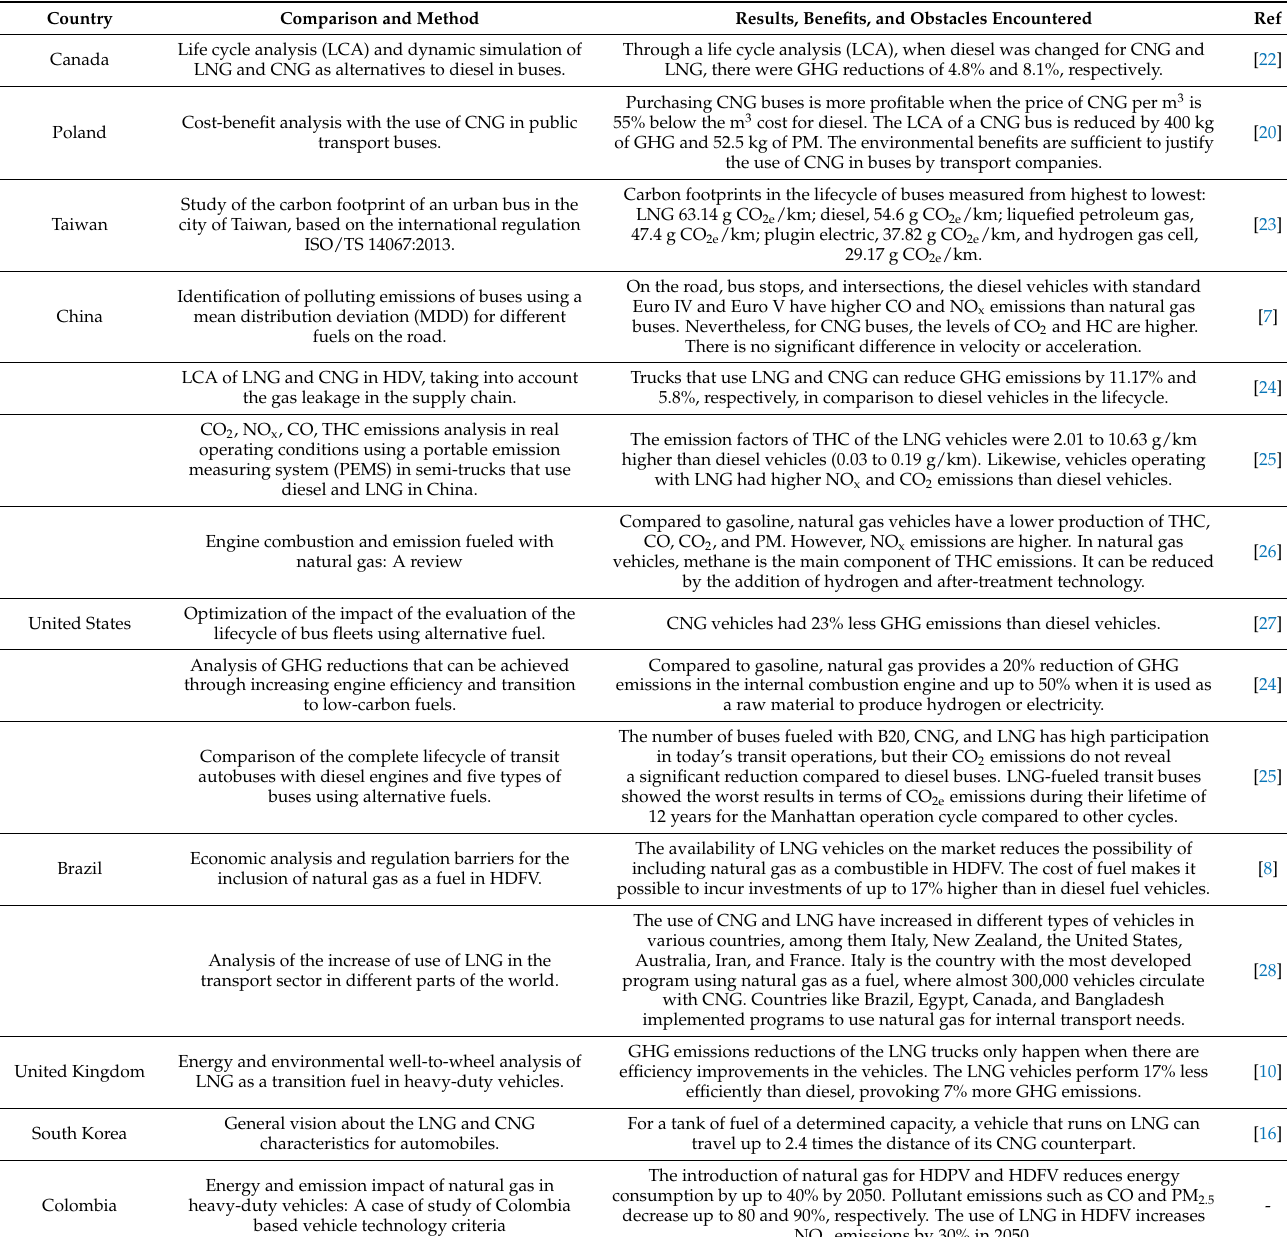
Table 1. Studies related to the evaluation of natural gas in HDV in the